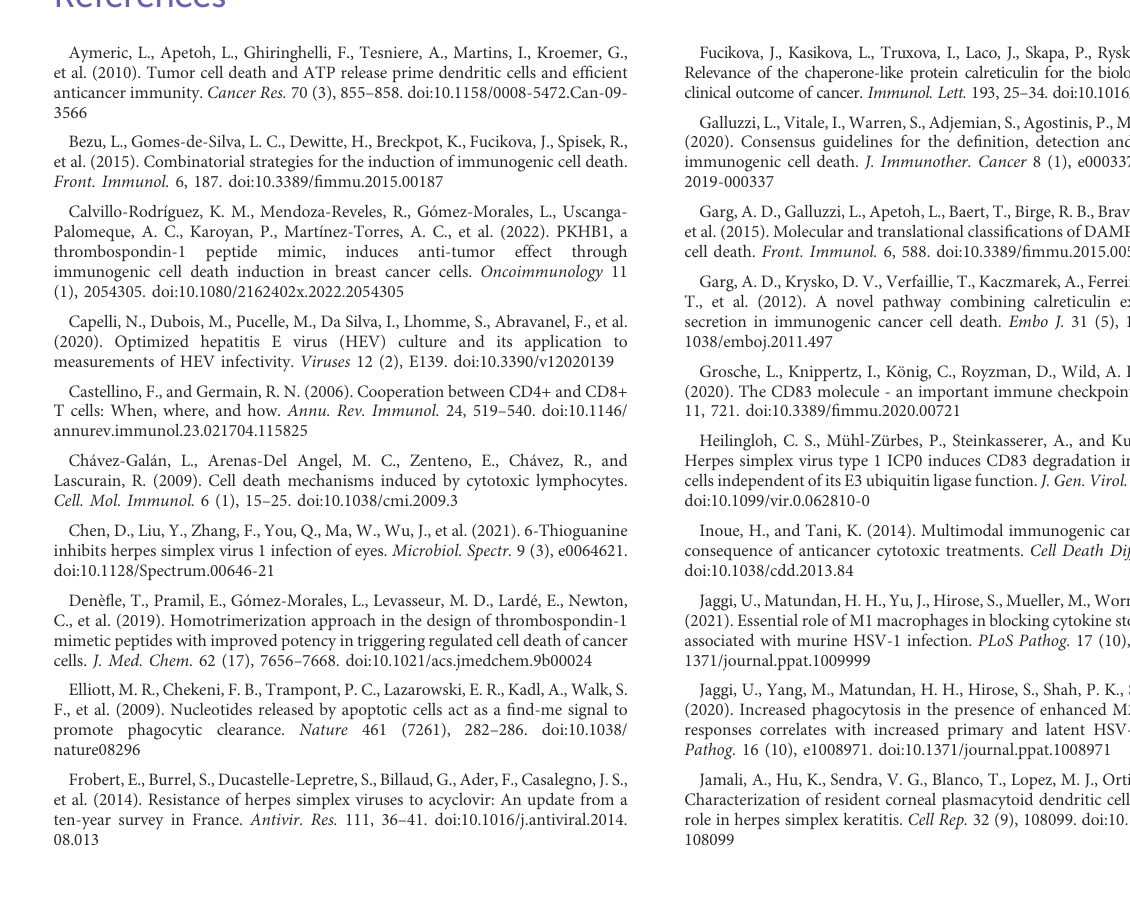
SUPPLEMENTARY FIGURE S1 Flowcytometrygatingstrategies. (A) GatingstrategiesforLive/Deadcells. (B) Gating strategies for CD45 + Live lymphocytes expressing F4/80, CD11b and CD86 were gated to analyze macrophages percentage. (C) Gating strategies for CD45 + Live lymphocytes expressing CD11c and MHC- II were gatedto analyze DCs percentage. (D) Gating strategies for CD45 + Live lymphocytes expressing CD4 and CD8 were gated to analyze T cells percentage. (E) Gating strategies for isotype control. SUPPLEMENTARY FIGURE S2 Mice eyes images. (A) Images taken after sub-conjunctival injection and before infection. (B) Contralateral eye images. (C) Fluorescein staining images of all animals. SUPPLEMENTARY FIGURE S3 Cell fl uorescenceimages.InfectedHCECswereincubatedby fl uorescent secondary antibody and DAPI without CALR antibody